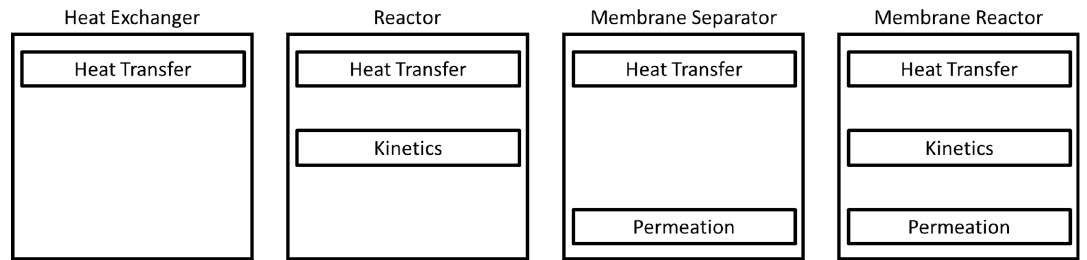
Figure 2. A breakdown of the individual phenomena that take place in each unit operation.